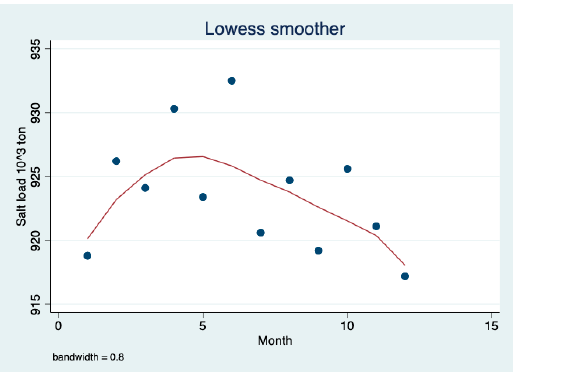
Figure 14. Lowess smoother (0.8 bandwidth) trend of changes plot of monthly changes of WL (mbsl) (1969–2001).